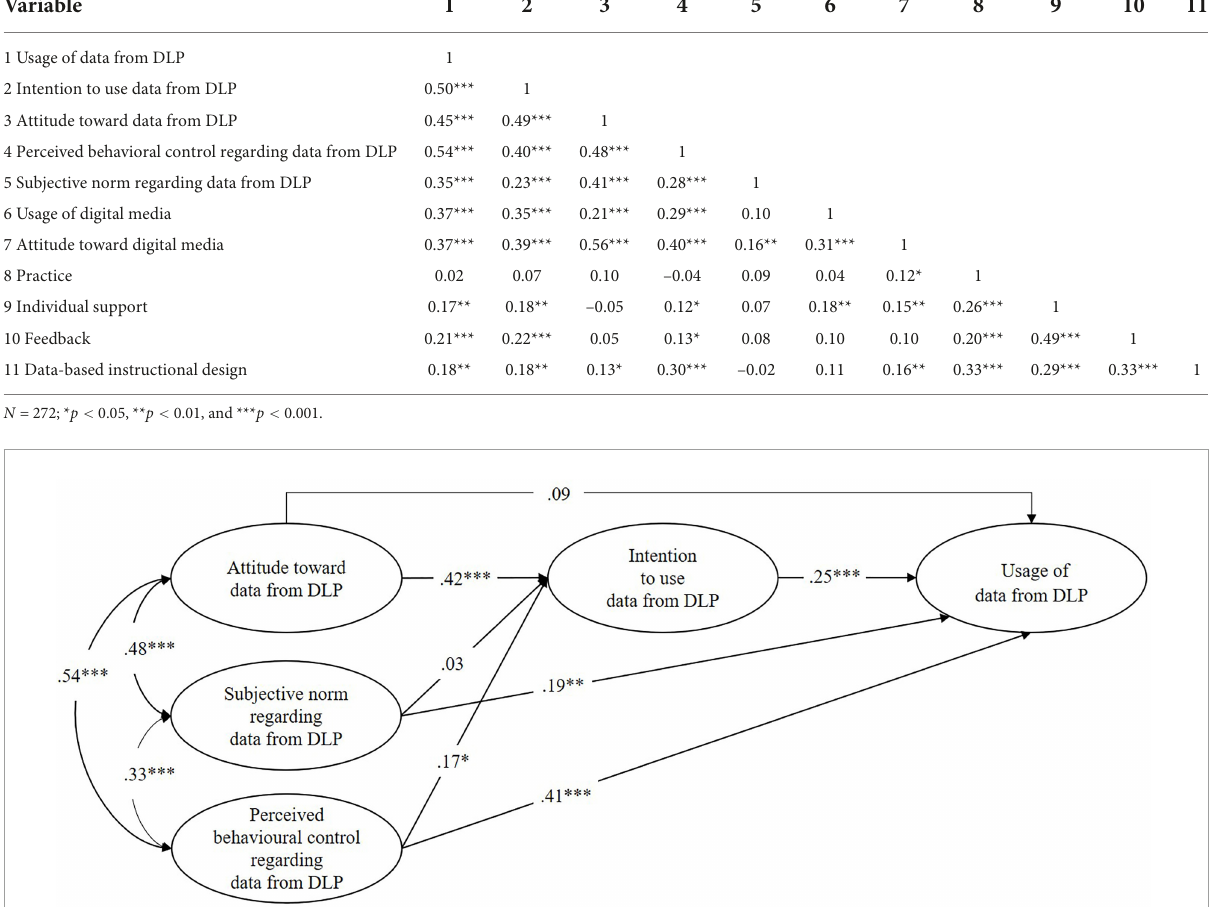
TABLE 3 Correlation matrix of all factors for all participants. Variable